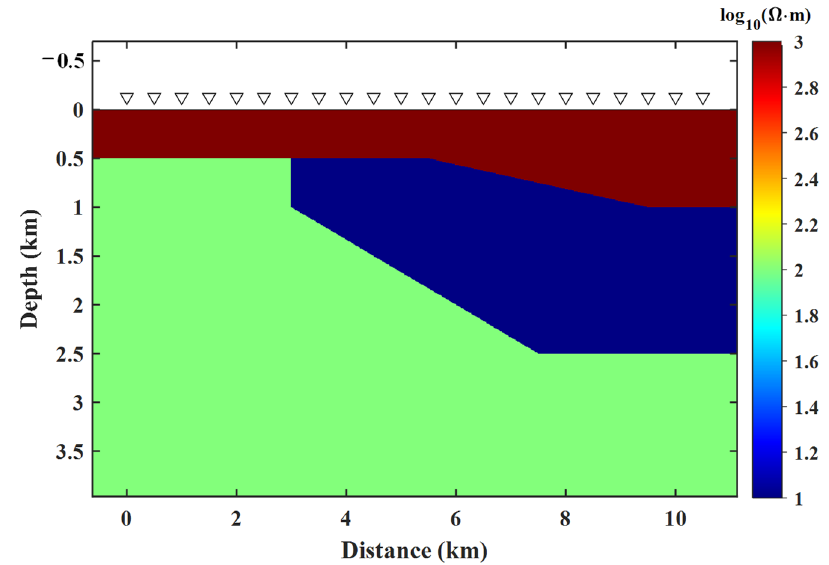
Figure 5. Diagram of the wedge model.